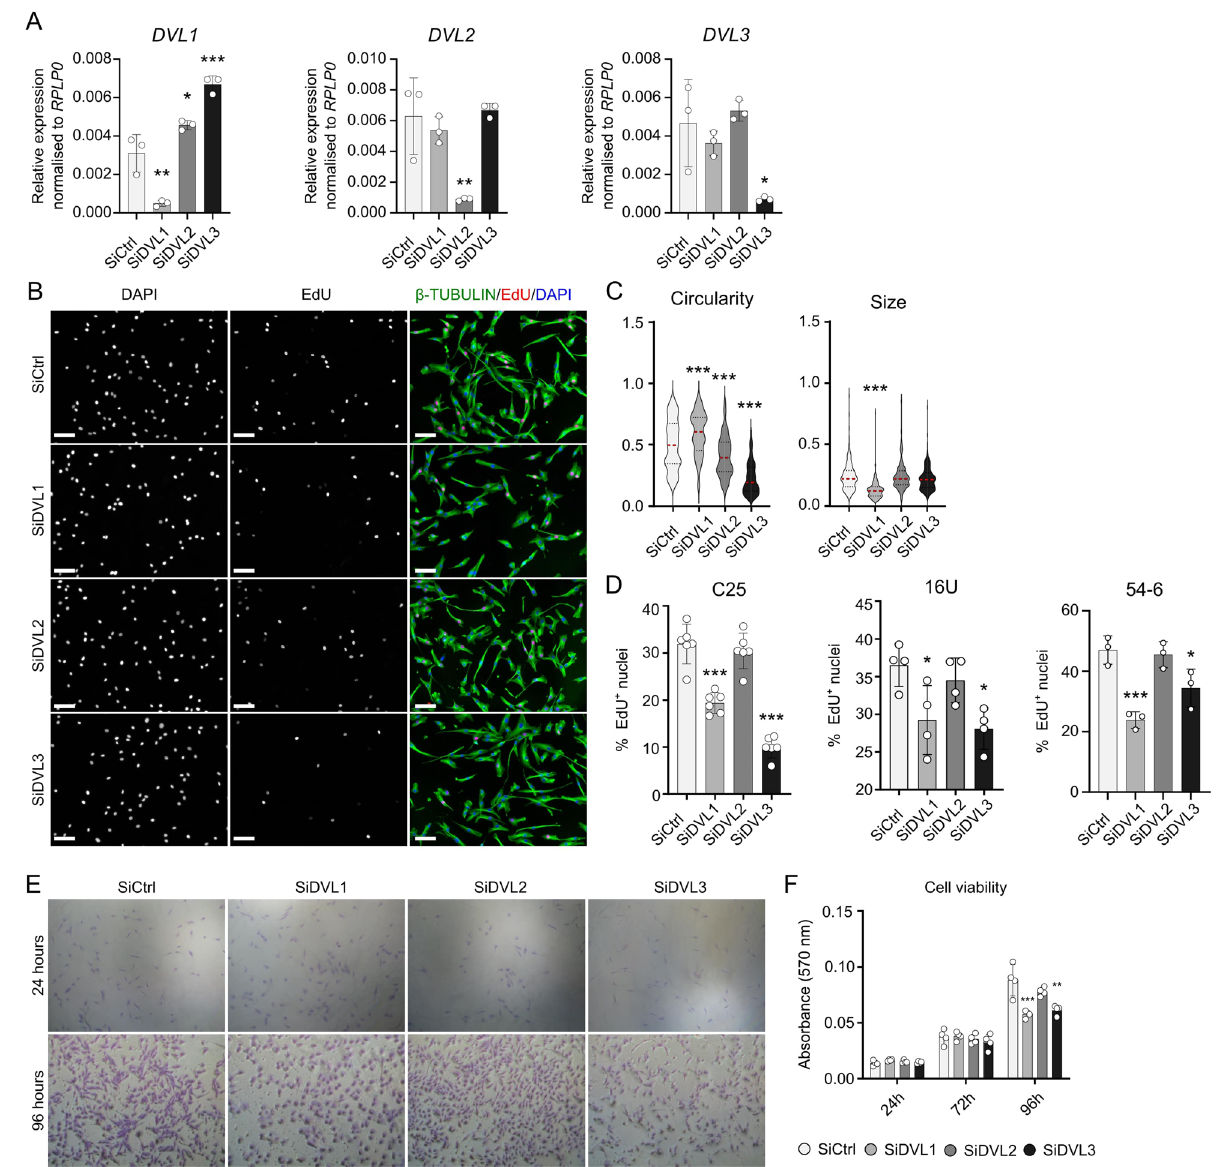
Figure 2. Knockdown of DVL1 or DVL3 reduces proliferation in human myoblasts. ( A ) Gene expression levels of DVL1 (left), DVL2 (middle) and DVL3 (right) in proliferating C25 myoblasts after knockdown of each isoform for 48 h. N = 3 biological replicates. Data is represented as mean ± SD with significant differences calculated using a One-Way ANOVA with Dunett’s post-hoc test, comparing each group with the control (SiCtrl), where an asterisk denotes p < 0.05, two asterisks p < 0.01 and 3 asterisks p < 0.001. ( B ) Representative images of proliferating C25 myoblasts after knockdown of each DVL isoform for 48 h, immunolabelled for β-TUBULIN (green) to show cell morphology, with nuclei counterstained with DAPI (blue). Incorporated EdU is also visualised (red). Scale bar represents 100 µm. ( C ) Quantification cell circularity (0 equates to a straight line, 1 to a perfect circle) and size in proliferating C25 myoblasts after knockdown of each DVL isoform for 48 h, displayed as violin plots. Red line demarcates mean. Statistically significant differences were assessed using a One Way ANOVA with a Dunett’s post hoc test, comparing each knockdown individually to the control (SiCtrl). N = 135 cells from 3 independent experiments. Three asterisks denote p < 0.001. ( D ) Quantification of the percentage of human C25, 16U and 54–6 myoblasts that had incorporated EdU after knockdown of each DVL isoform. More than 200 nuclei were analysed for each of N = 3–6 wells. ( E ) Crystal violet staining of C25 myoblasts after DVL knockdown after 24 or 96 h of proliferation. ( F ) Quantification of crystal violet incorporation in C25 myoblasts after DVL knockdown after 24, 72 and 96 h of proliferation. N = 4. Data is represented as mean ± SD. Statistical differences were assessed using a One-Way ANOVA with Dunett’s post hoc test, comparing each knockdown group with the control, for each time-point, where two asterisks denote p < 0.01 and three asterisks p <